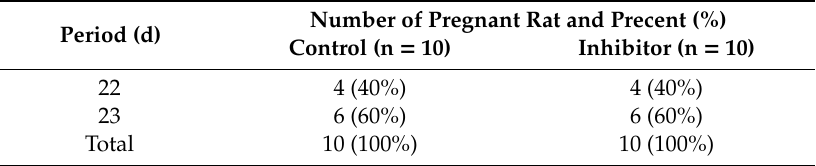
Table 4. E ff ects of GABA-T inhibitor treatment on pregnancy in female rats. Number of Pregnant Rat and Precent (%) Period (d) Control (n = 10) Inhibitor (n = 10) 22 4 (40%) 4 (40%) 23 6 (60%) 6 (60%) Total 10 (100%) 10 (100%) Vigabatrin was used as a GABA-T inhibitor.